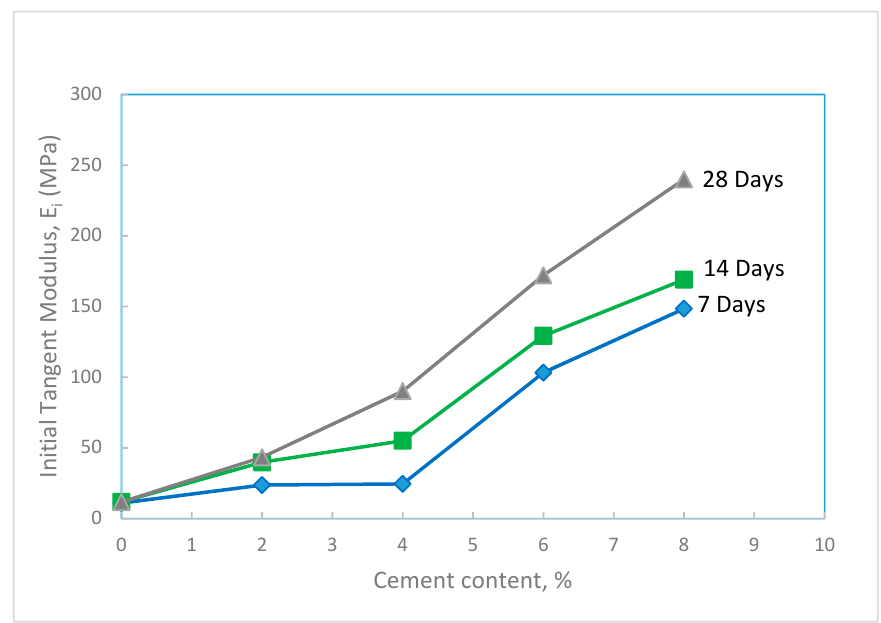
Figure 11. Variation of initial tangent modulus of the treated waste sand with cement content for different curing times.